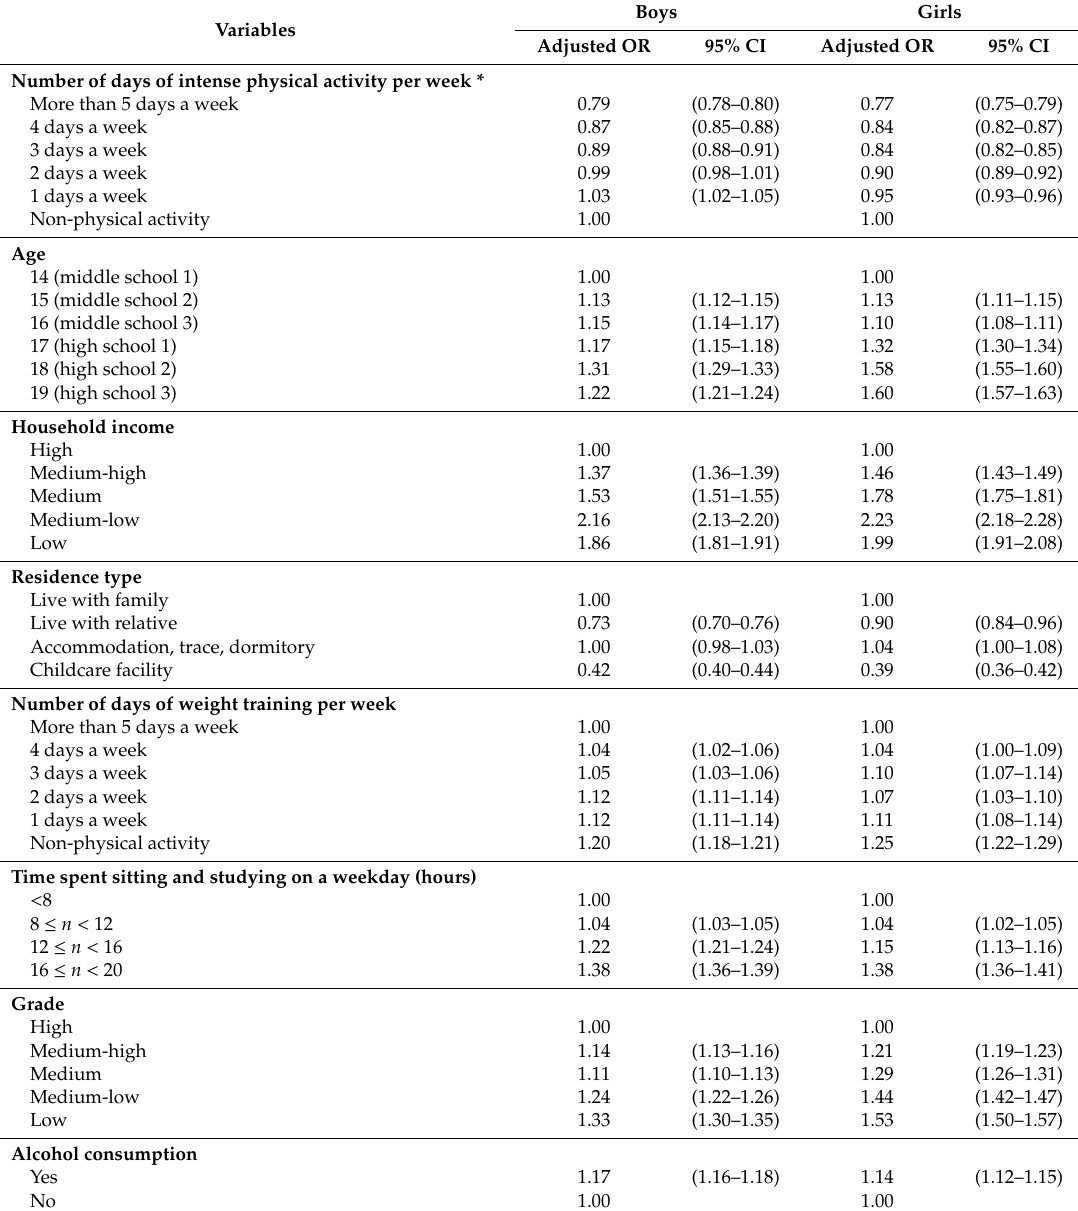
Table 2. Adjusted association factors associated with physical activity and stress